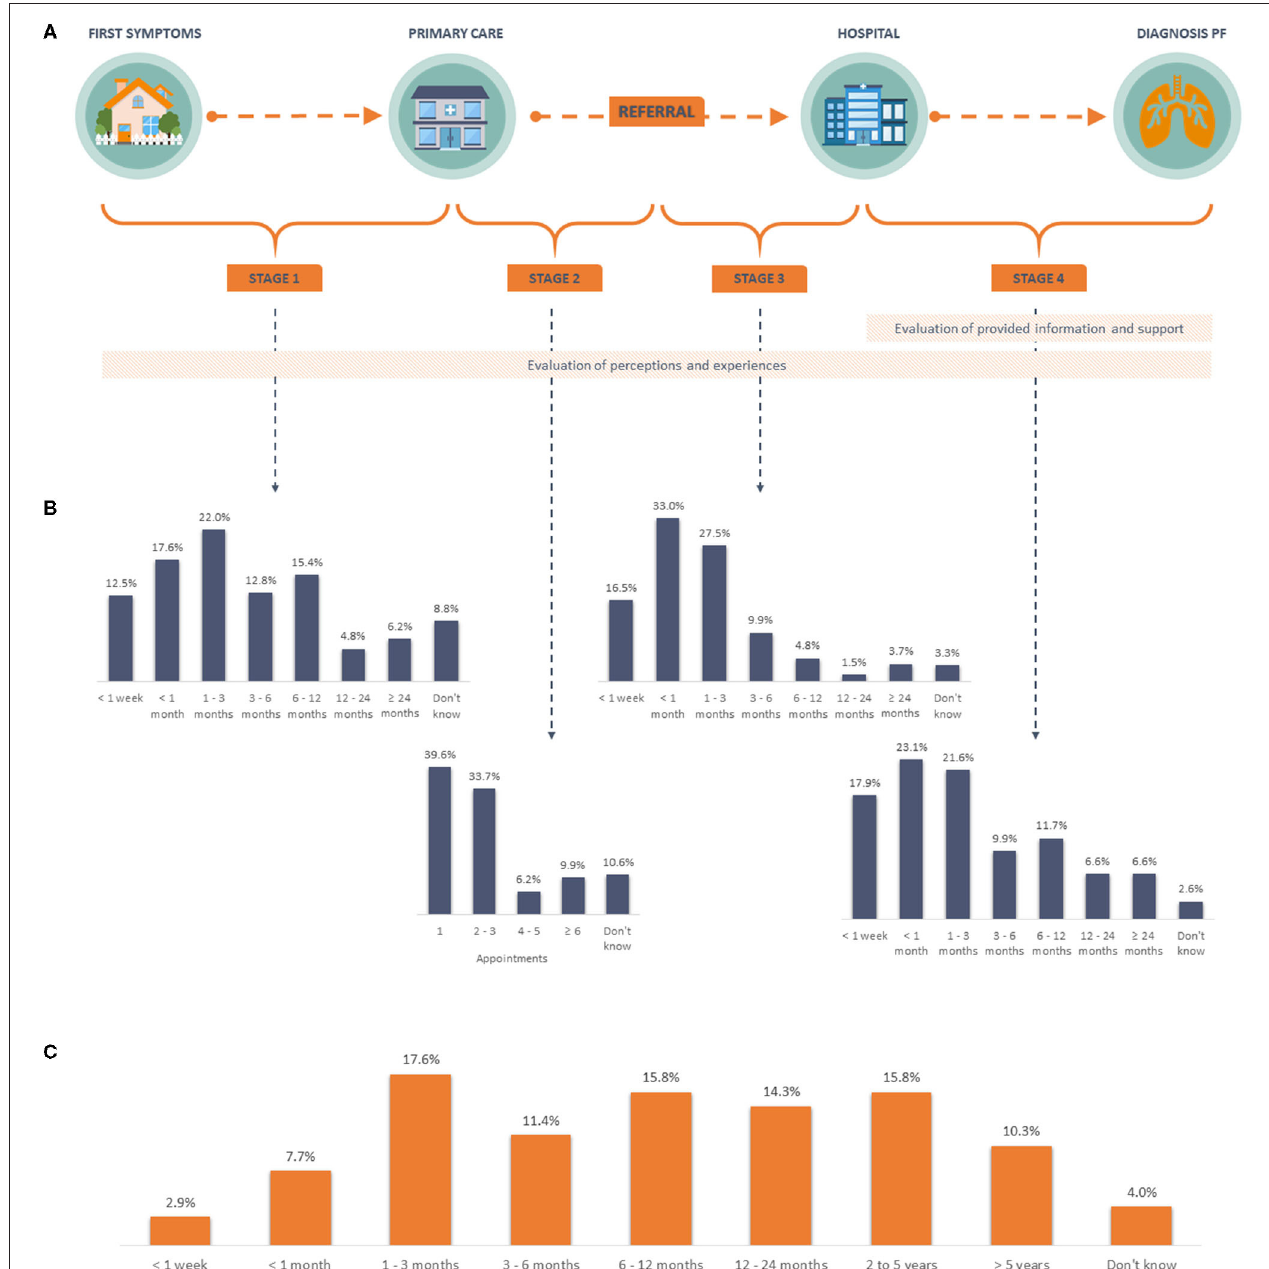
FIGURE 1 | Diagnostic pathway and time to diagnosis. (A) Schematic overview of the diagnostic pathway for pulmonary fibrosis, including stages and topics assessed in the survey. (B) Patient reported time per stage. (C) Patient reported overall time to diagnosis. PF, pulmonary fibrosis.